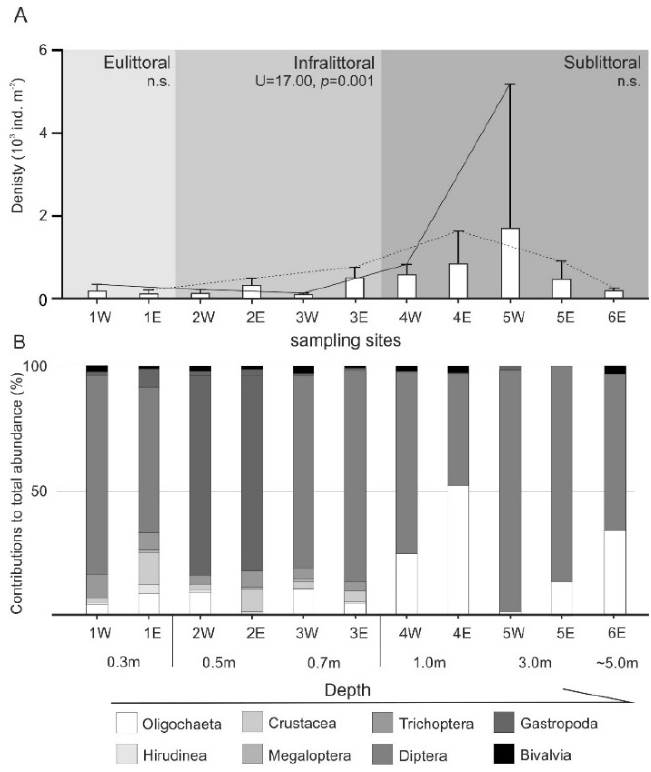
Figure 3. ( A ) Abundance of macroinvertebrates in different zones of two segments of Lake Wicko (W-western, E—eastern). The significance between the two lake segments (Mann–Whitney U test, n Bonferroni’s correction of p -values) is also reported, (n.s. = not significant). ( B ) Contribution of identified taxa in the total abundance of macroinvertebrates (%).